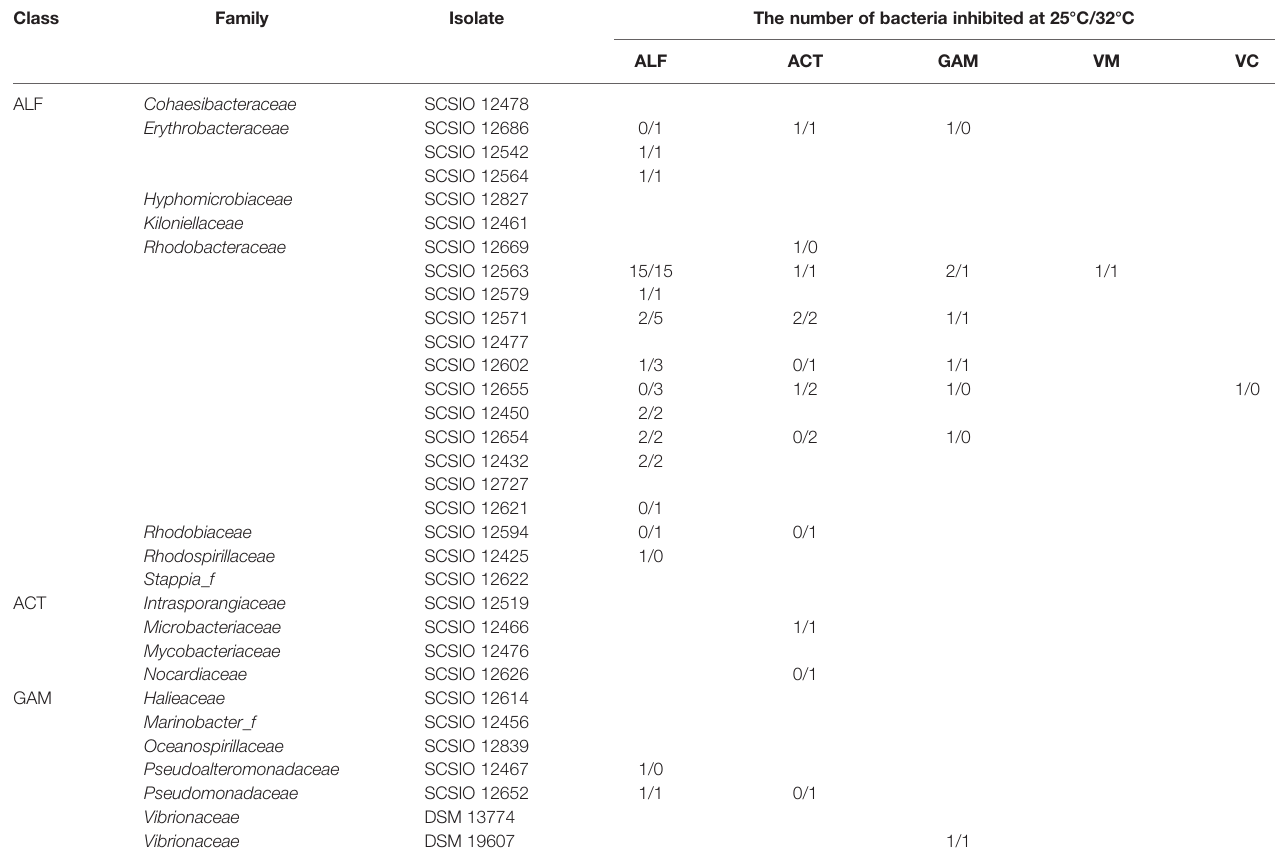
TABLE 1 | Inhibitory activity of coral-associated bacteria.